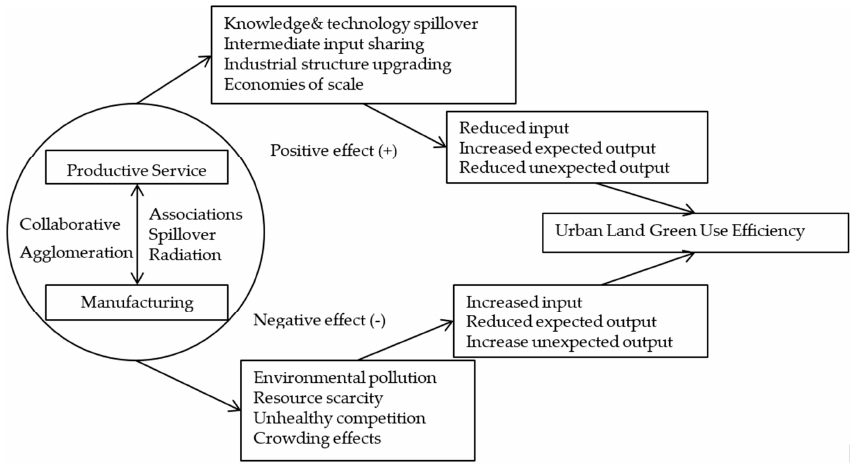
Figure 1. The transmission mechanism of industrial agglomeration impacting urban land green use e ffi ciency.